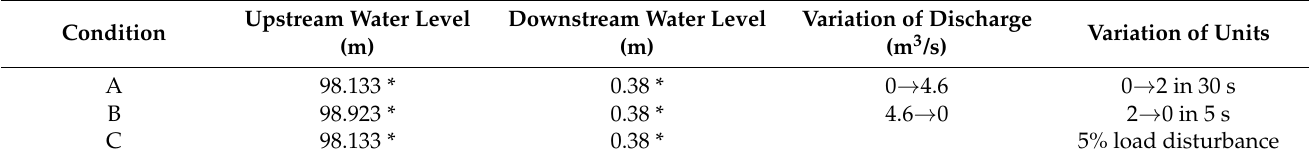
Table 4. Representative conditions under transient load